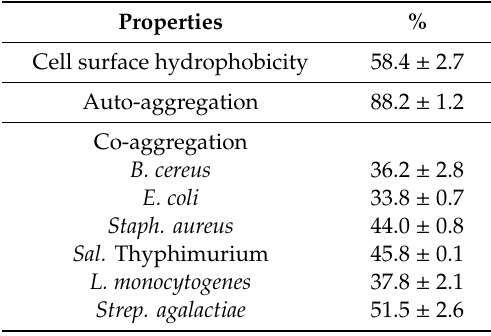
Table 1. Cell surface hydrophobicity, auto-aggregation and co-aggregation against pathogenic bacteria.